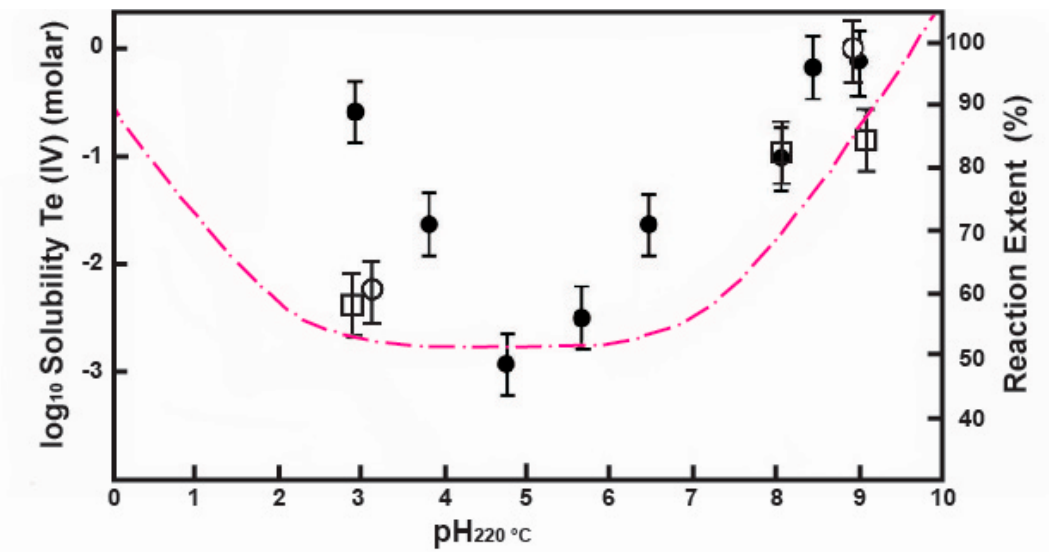
Figure 7. The curve of estimated solubility of Te(IV) in water at 220 °C is shown as pink dashed line (data from reference [28,38,39]). Solid circles stand for the reaction extent of the replacement of calaverite [28]. Hollow circles and squares stand for the replacement of krennerite [17] and sylvanite [16], respectively. Errors of the reaction extent (3 − σ ; ± 6%) are plotted at each point. Reaction extent observed experimentally corresponded well to the solubility of tellurium.